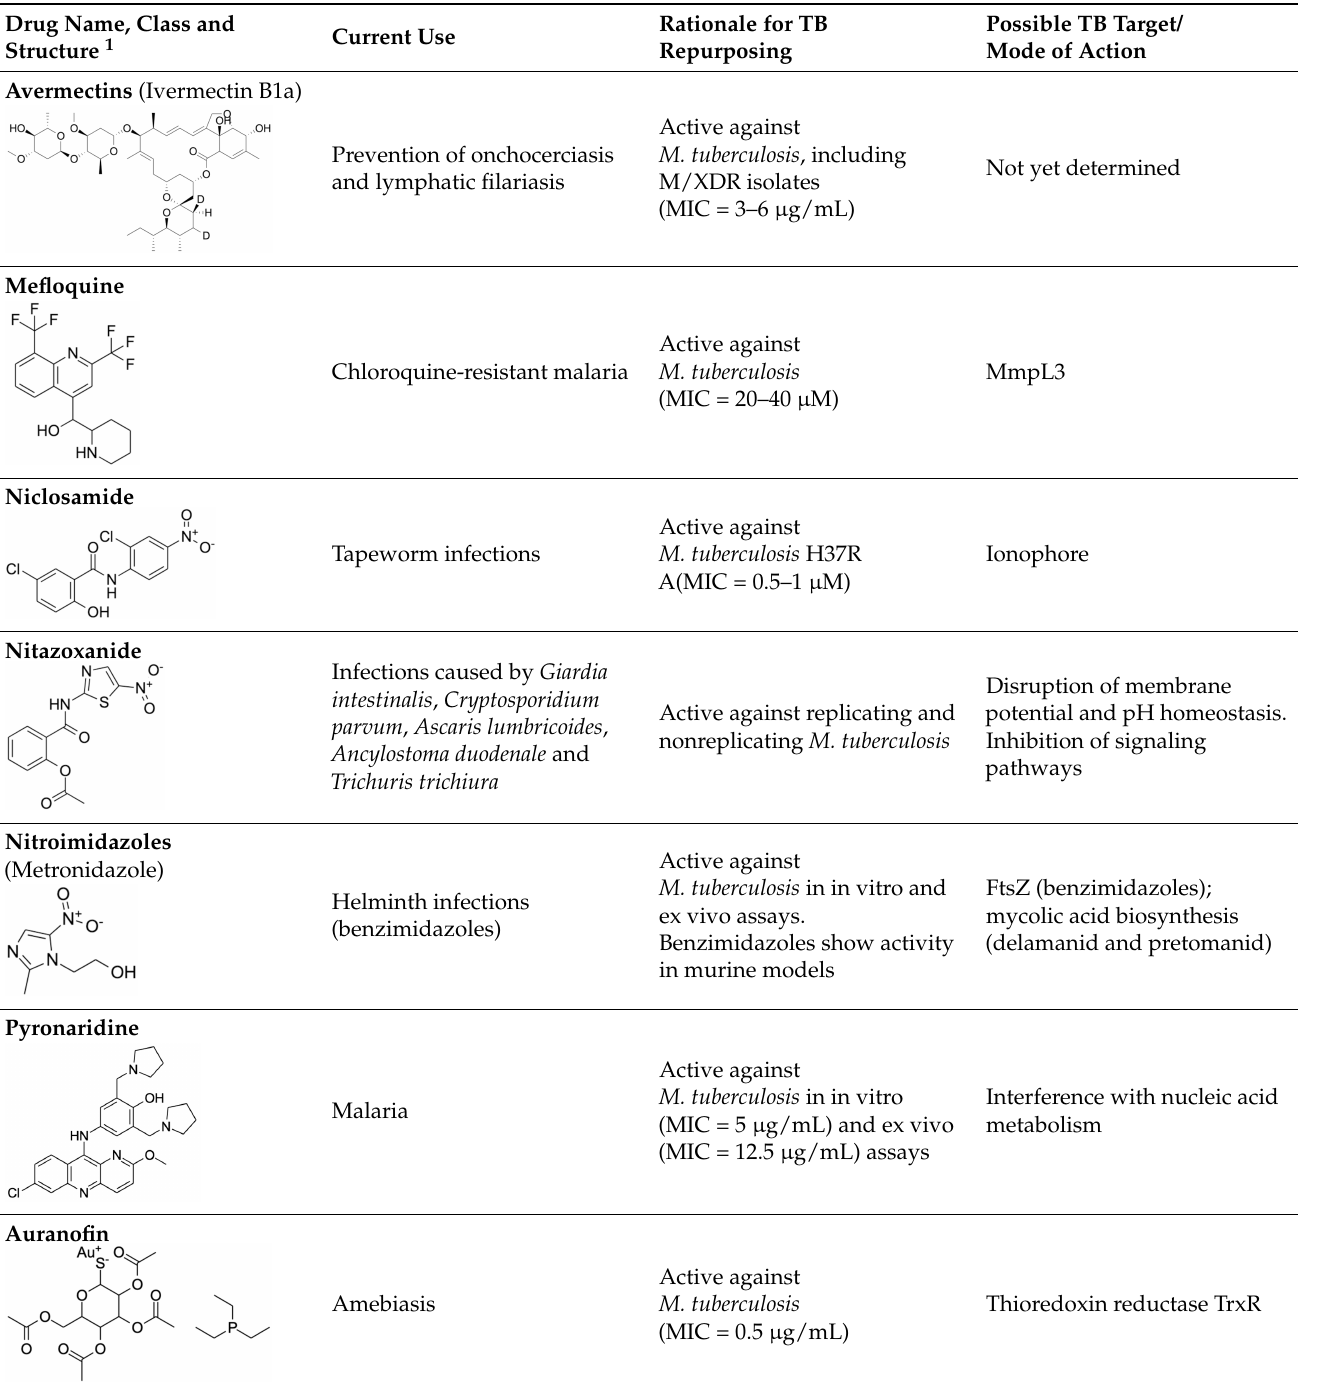
Table 1. Main antiparasitic drugs that are being studied to be repurposed for TB